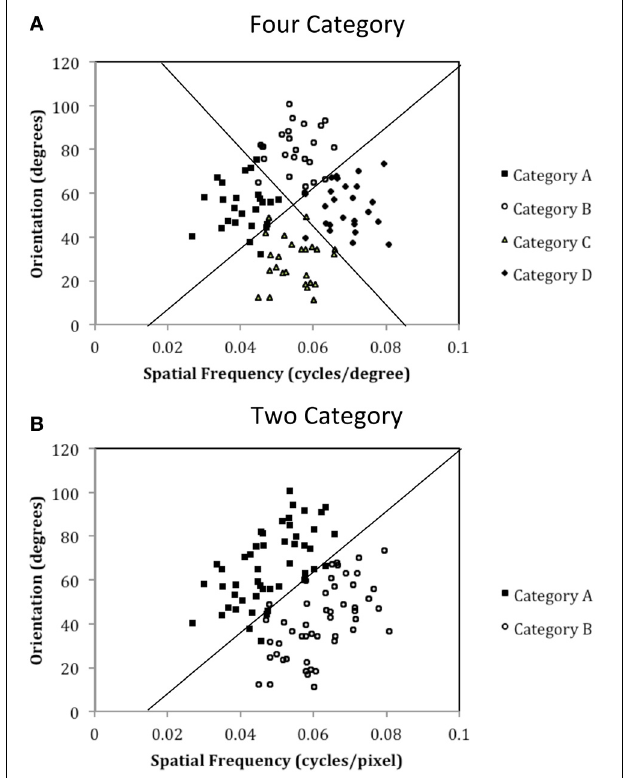
FIGURE 4 | Stimulus distributions for (A) the Four-Category and (B) Two-Category conditions in Experiment 1. The solid line(s) represent the optimal